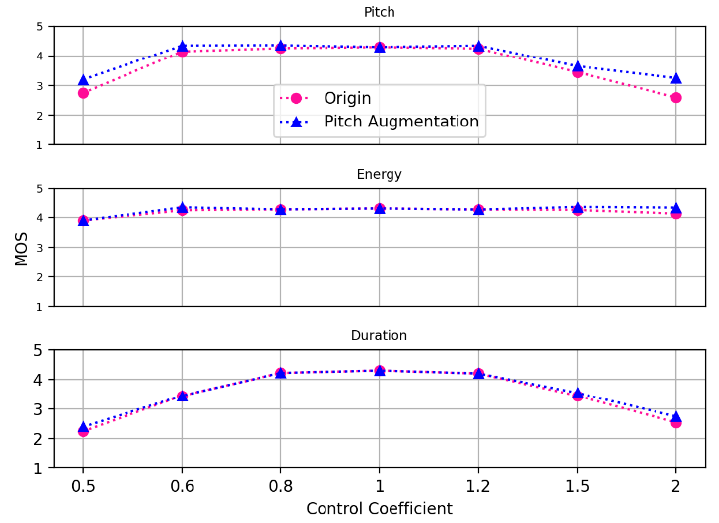
Figure 8. Subjective rating chart of scaling factor change.